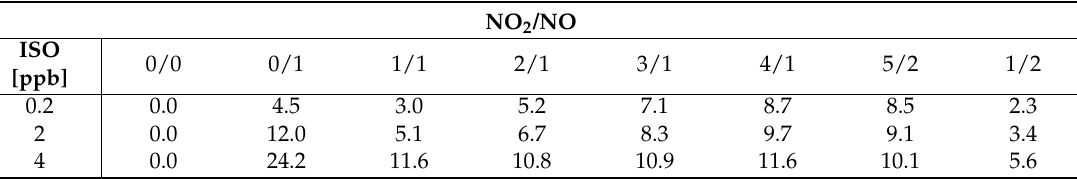
Figure 6. Simulated ozone concentrations for three different initial isoprene concentrations and six different NO 2 /NO-ratios ( a )–( f ). Mean daily ozone yield for different NO 2 /NO ratios and varying initial isoprene